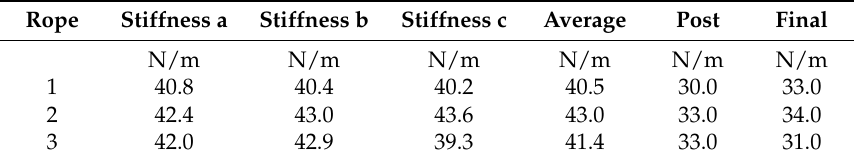
Figure 8. Load-elongation curve for the three lines used in the experimental mooring system.